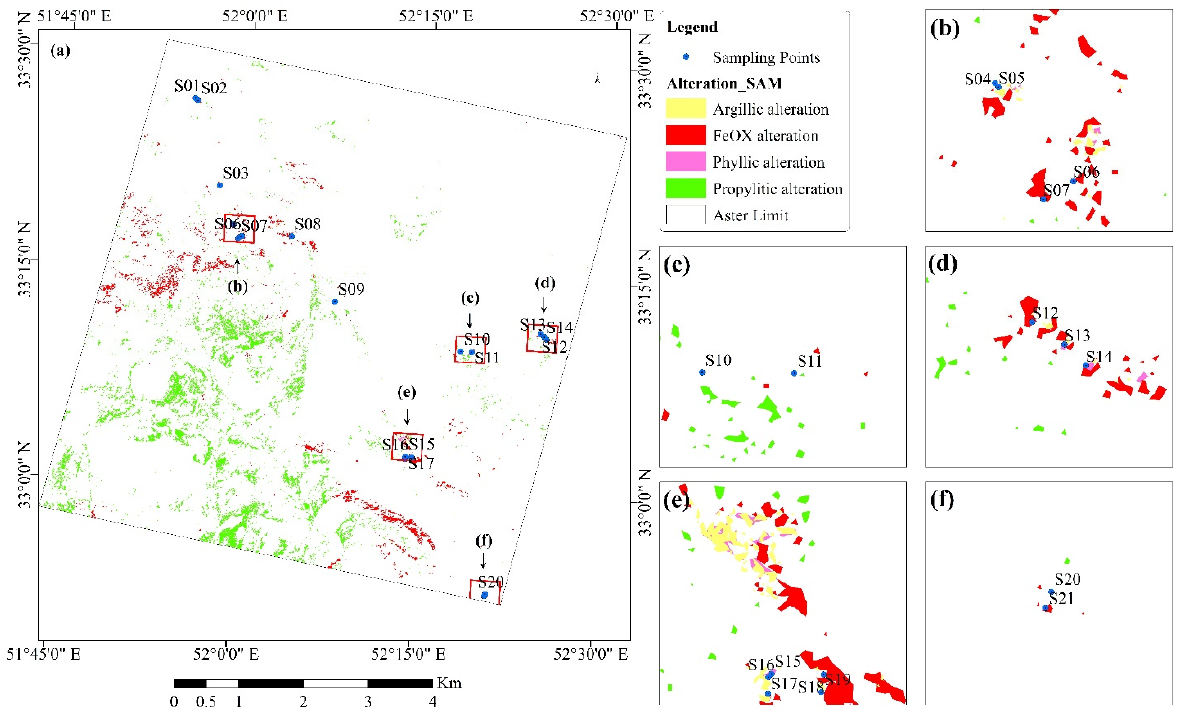
Figure 10. ( a ) The results of SAM spectral mapping on the ASTER data. ( a ) ASTER full scene of the study area. ( b – f ) Selected subsets for sampling and field survey.